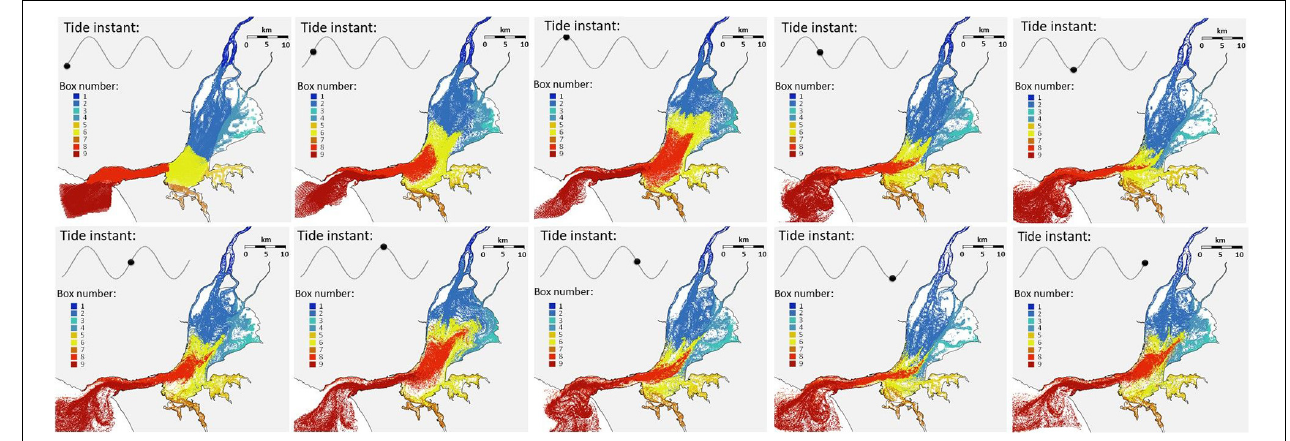
FIGURE 6 | Location of the tracers at different tidal points and for all boxes over about two first tidal cycles of the simulation and for the CS2 (medium river